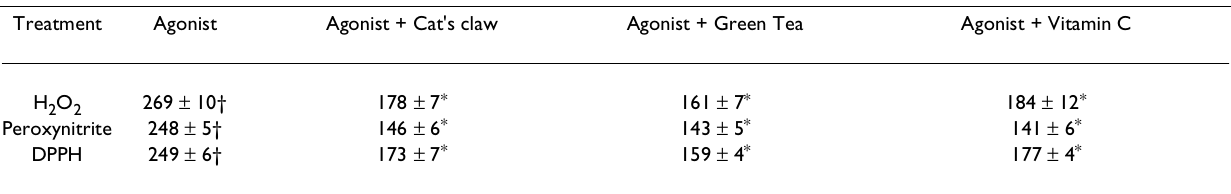
Table 1: Apoptosis Induction by Oxidants in IEC-18 cells and the Anti-apoptotic Effects of Dietary Antioxidants. Treatment